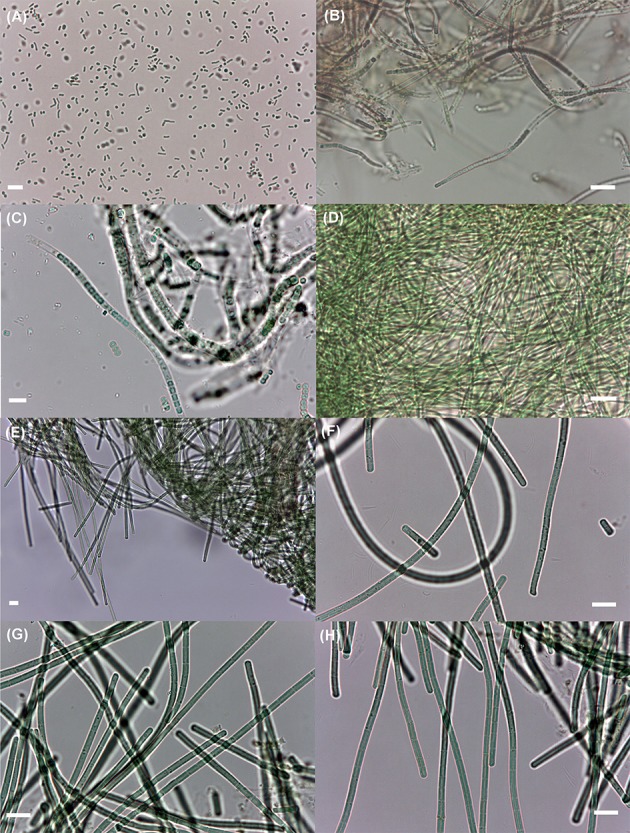
Cyanobacterial isolates obtained in this study. (A) The small, unicellular Synechococcus sp. LEGE 11394; (B) the brownish, filamentous Leptolyngbya aff. ectocarpi LEGE 11389; (C) the sheathed filamentous Nodosilinea sp. LEGE 11395; (D) the thin, filamentous Leptolyngbya sp. LEGE 11392; (E)
Geitlerinema cf. lemmermannii LEGE 11390, at 400× magnification; (F–H) the same non-sheathed filamentous species as in (E), at 1,000× magnification; strains LEGE 11393, 11391, and LEGE 11396, respectively. The short filaments in (F) are hormogonia. Scale bar: 10 μm.